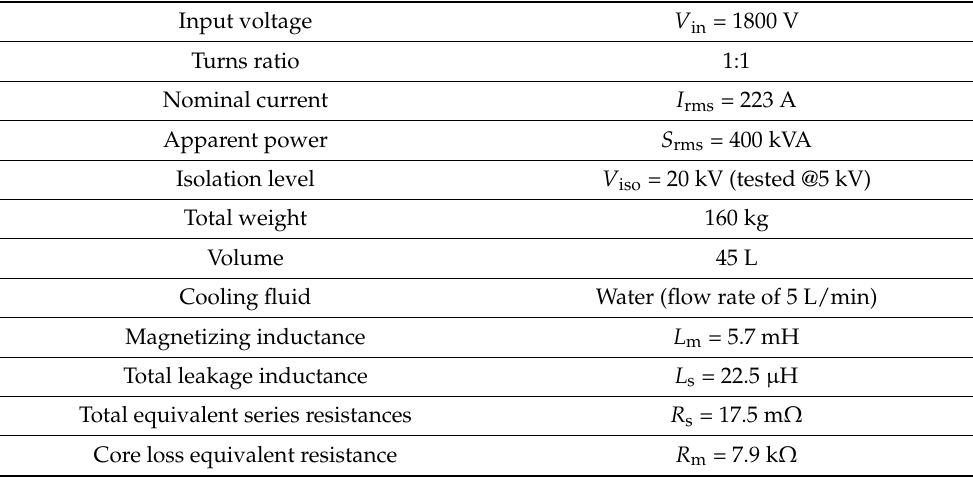
Table 2. Isolated DC/DC converter prototype: MFT specifications